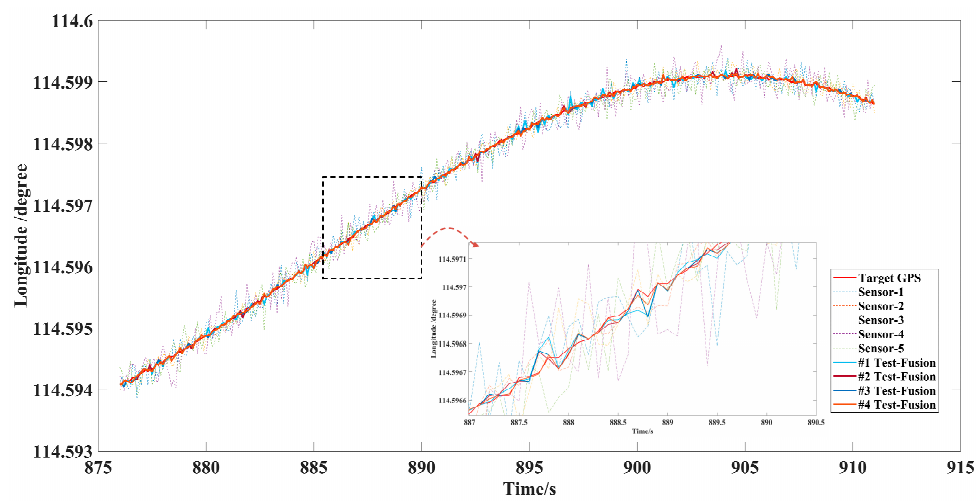
Figure 8. Longitude error of multisensor data fusion target trajectory.